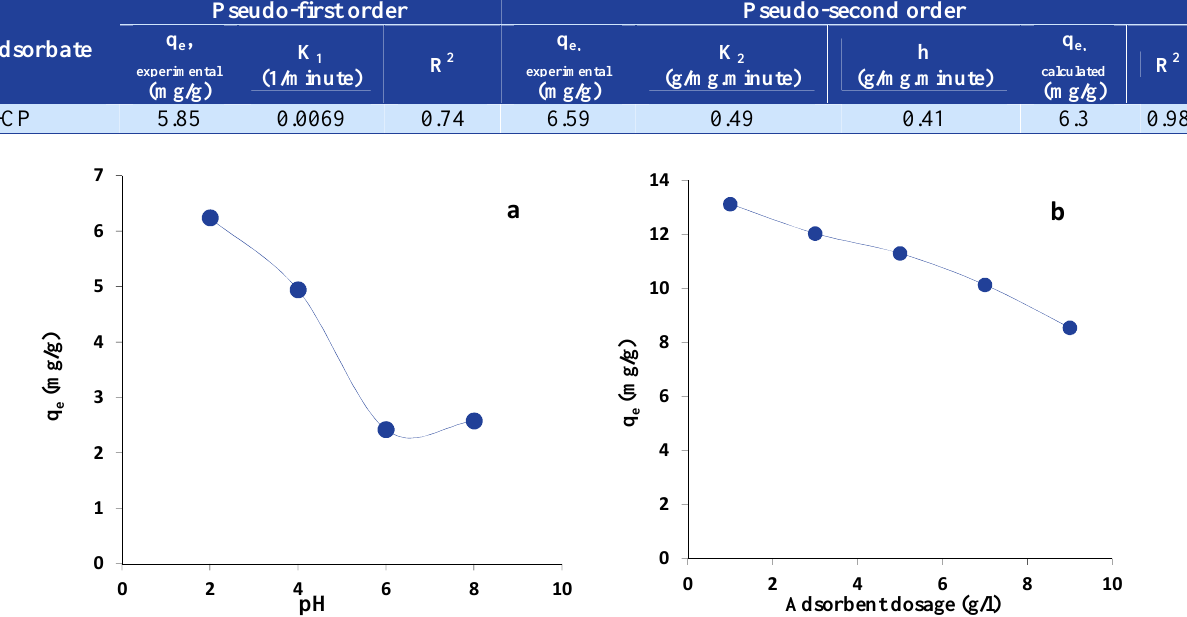
Table 1. Parameters of pseudo-first order kinetic and pseudo-second order kinetic models Adsorbate